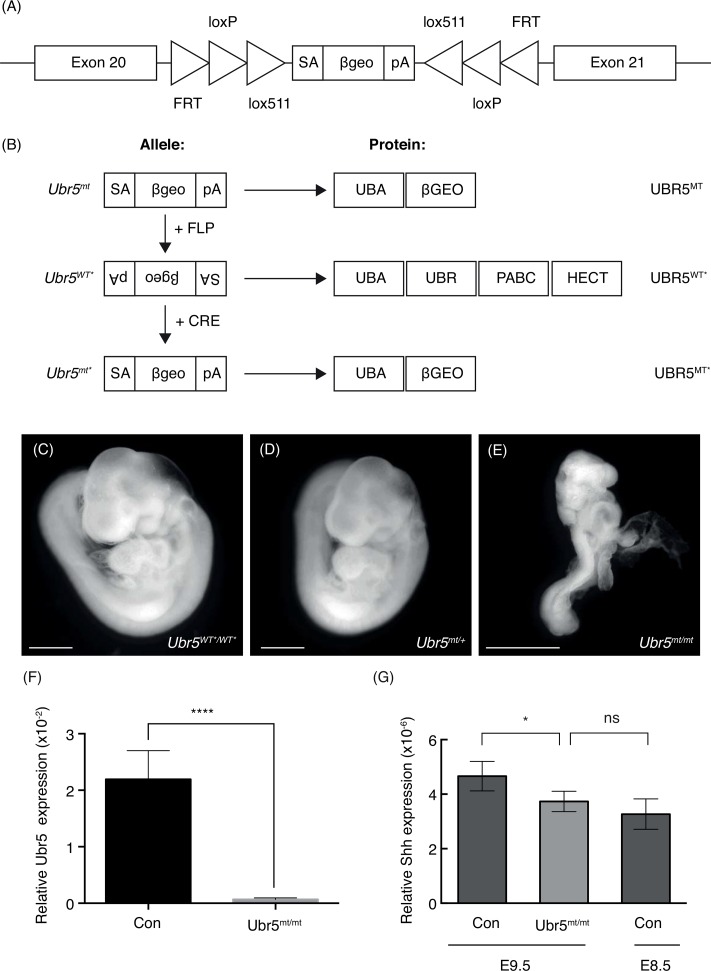
The Ubr5 gene trap phenocopies the Ubr5 null phenotype.(A) Schematic representation of the EUCOMM EUCE0171f01 gene trap introduced in between exons 20 and 21 of the murine Ubr5 gene. FRT, loxP and lox511 recombination sites, and their orientation, are indicated as triangles and flank the gene trap encoding for a splice acceptor site (SA), a LacZ and neomycin CDS (βgeo) and a poly-adenylation signal (pA). (B) Schematic representation of the effects of FLP and Cre-mediated recombination on the gene trap and UBR5 protein/domain expression–see text for details. (C-E) Brightfield images of control (C) Ubr5WT*/WT*, (D) Ubr5mt/+ and (E) Ubr5mt/mt E9.5 embryos. Scale bar = 1mm. Whole embryo qRT-PCR analysis of (F) Ubr5 at E9.5 and (G) Shh expression in the indicated genotypes at E9.5 or E8.5. Con = Ubr5+/+. n = ≥ 6, s.e.m indicated. Statistical analysis by Students t-test. ns = not significant.